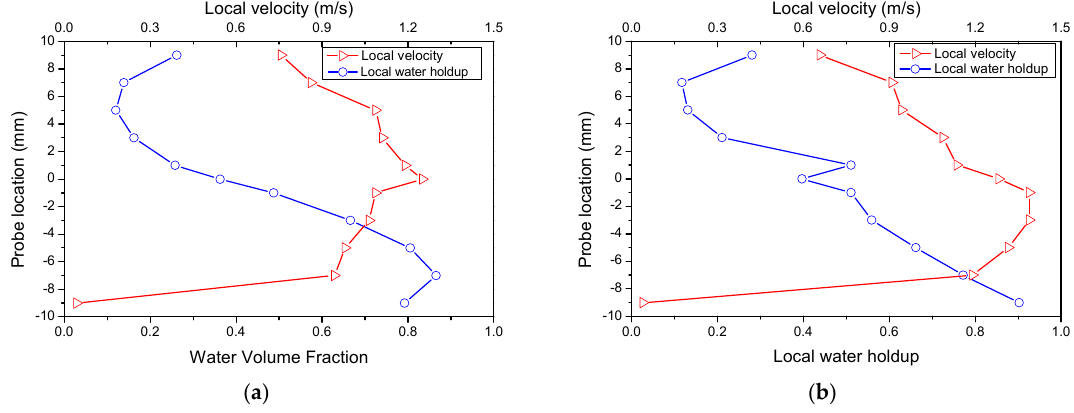
Figure 12. The profile of local velocity and local concentration in representative conditions with fixed oil phase superficial velocity U so = 0.51 m/s. ( a ) U sw = 0.51 m/s, dual continuous (DC) flow; ( b ) U sw = 0.62 m/s, DC flow.